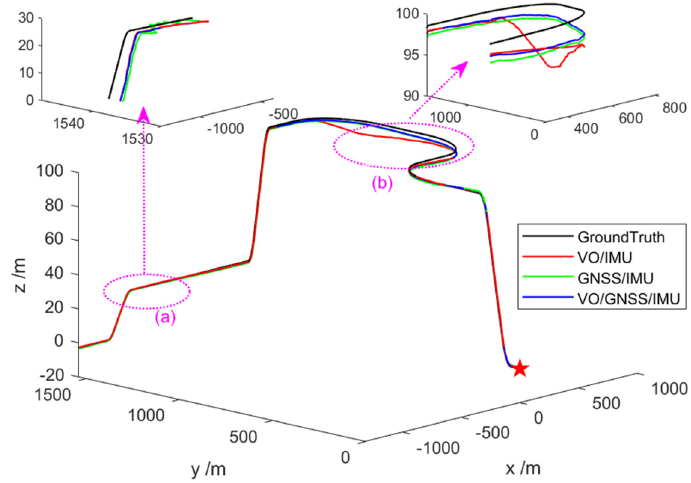
Figure 4. Comparison of state estimation of different combined systems. Asterisk indicates the starting position, the dotted line indicates the position of the enlarged area, and the arrow indicates the specific enlarged area ( a , b ).